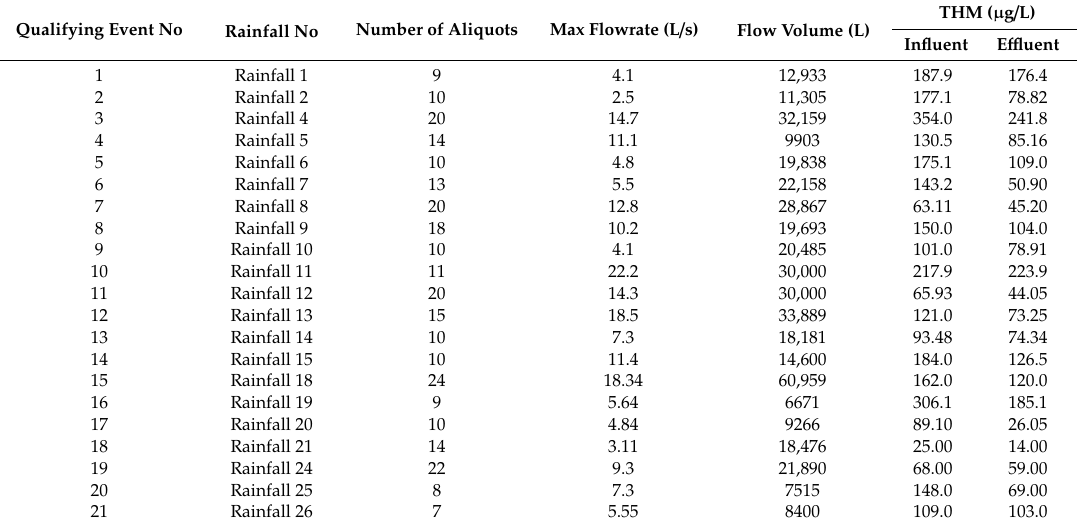
Table A4. THM influent and e ffl uent results ( LOD not